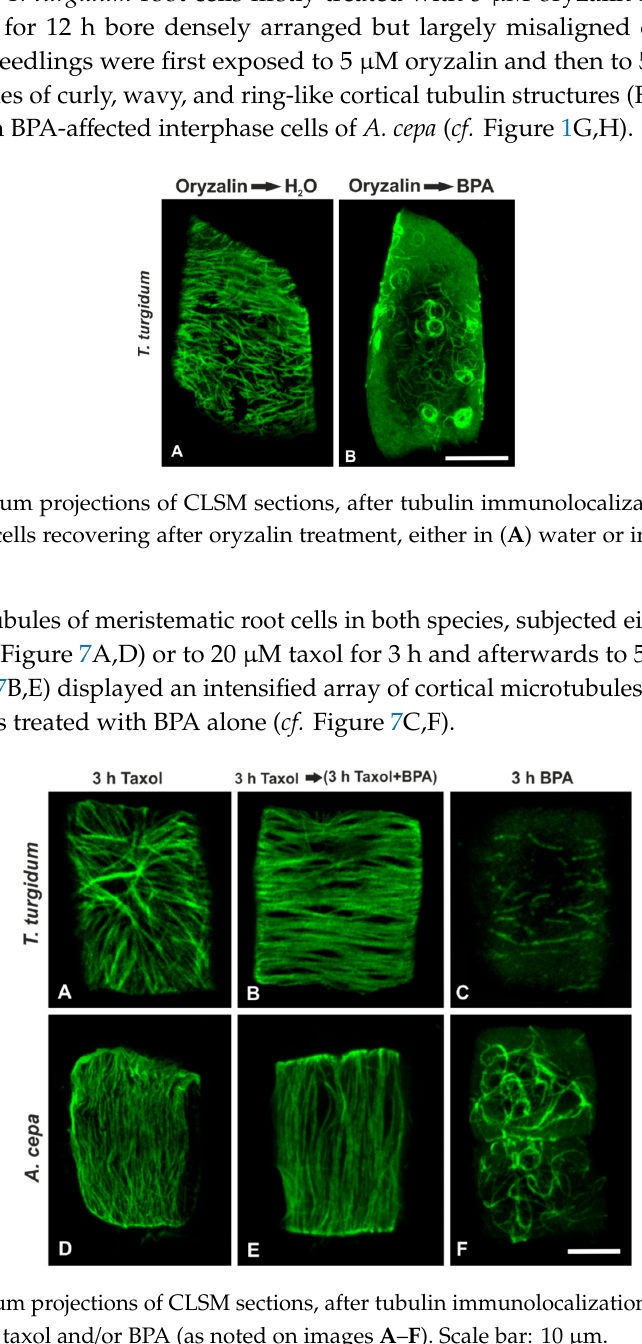
Figure 7. Maximum projections of CLSM sections, after tubulin immunolocalization in interphase root cells treated with taxol and/or BPA (as noted on images A – F ). Scale bar: 10 μ m.